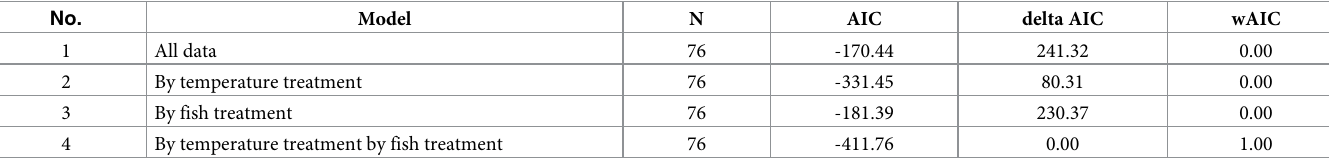
Table 3. Comparison of regression models testing the effects of temperature (ambient: 25˚C or hot: 32˚C) and fish presence (fish or no fish) on P . damicornis pho- tosynthetic efficiency (F V /F M ), fitting the data through the means for colonies within treatments for the Acclimation and Stress experimental periods during the manipulative thermal bleaching experiment. Akaike’s information criteria (AIC) and AIC differences ( Δ AIC) were calculated per model selection practice [58–60]. See S8 Table for calculations with individual points yielding similar results as mean models (mean model results presented here).